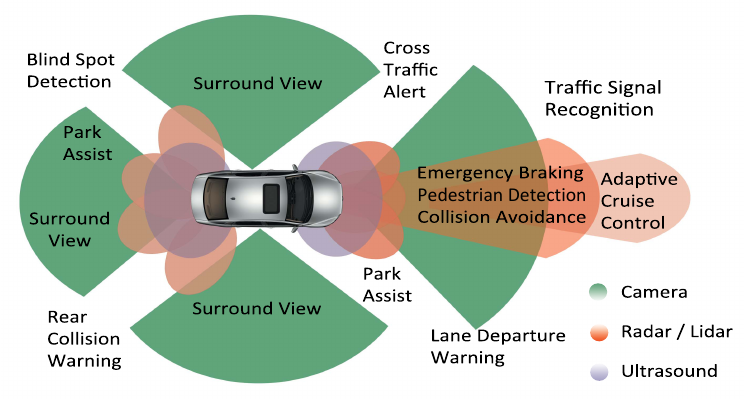
Figure 1. ADAS used in modern vehicles, source: adapted with permission from